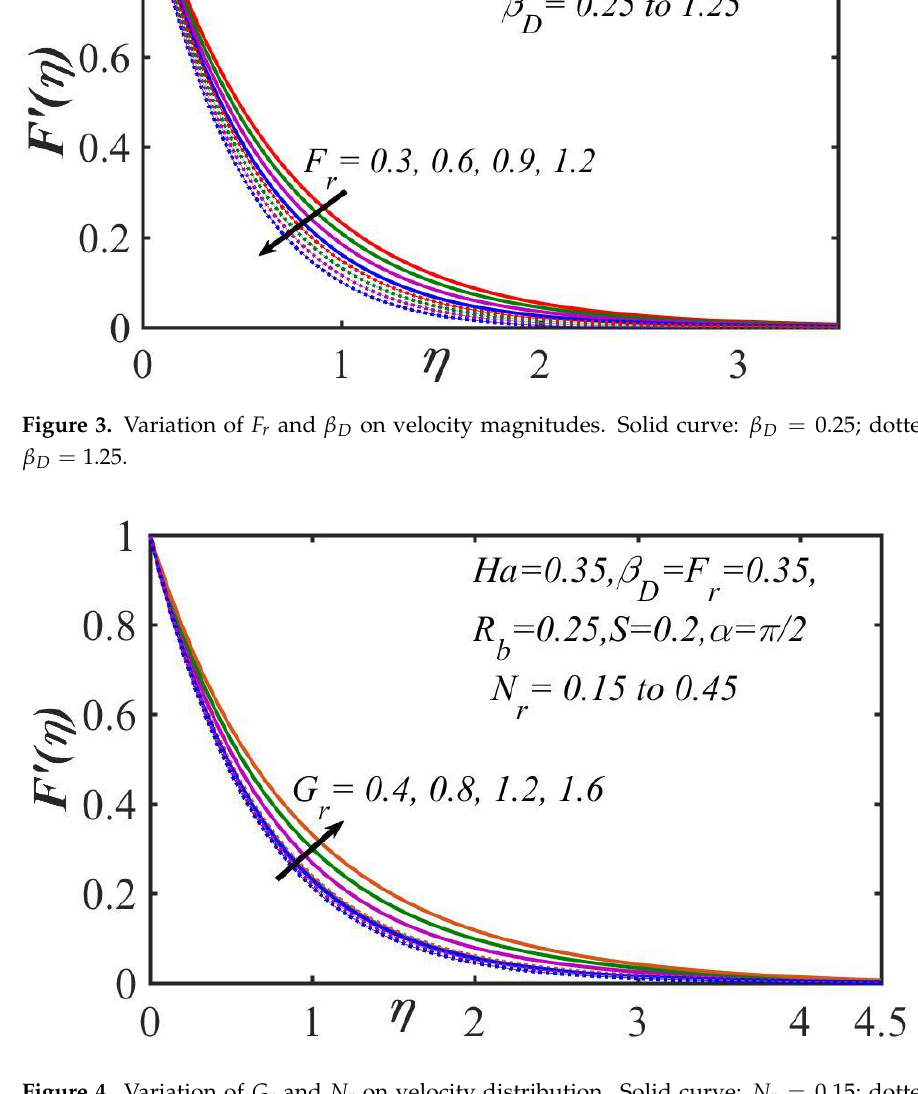
Figure 4. Variation of 𝐺 𝑟 and 𝑁 𝑟 on velocity distribution. Solid curve: 𝑁 𝑟 = 0.15 ; dotted curve: 𝑁 𝑟 = 0.45 .